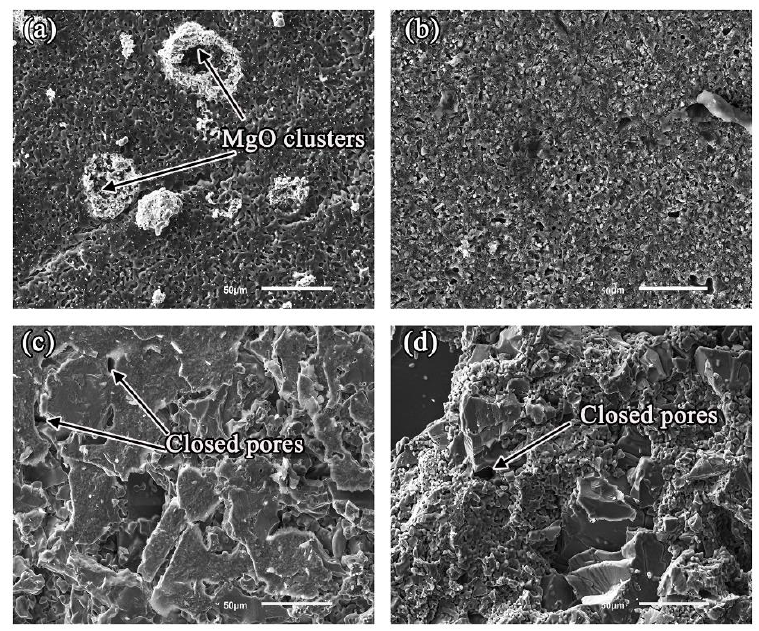
Figure 3. Microstructures of the various oxide ceramic substrates after wetting: ( a ) MgO; ( b ) Y 2 O 3 ; ( c ) Al 2 O 3 ; and ( d ) ZrO 2 .